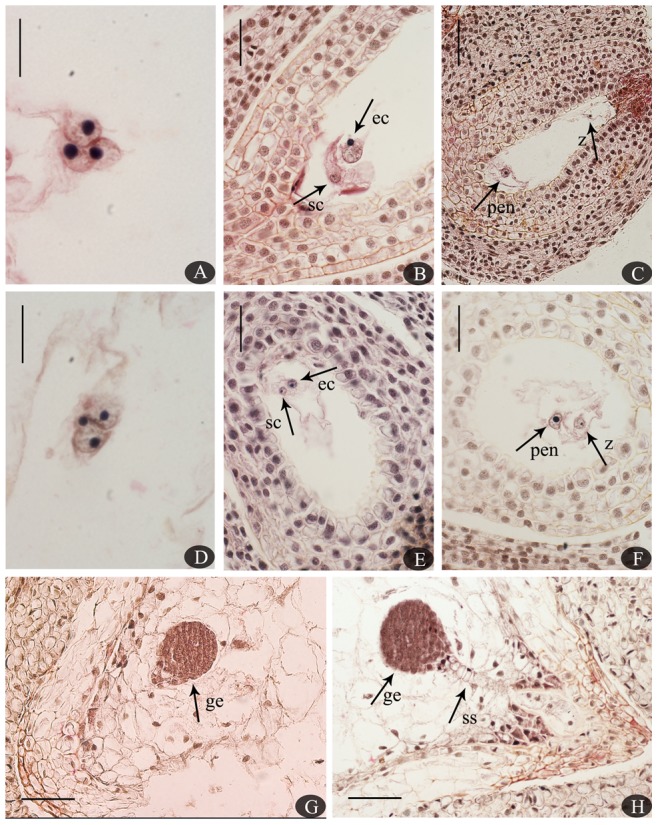
Normal double fertilization and early embryonic development after SP vs. CP in C. oleifera.(A). Polar nucleus fusion with a sperm nucleus 120 h after SP. (B). Sperm cell approaching an egg cell 96 h after SP. (C). A zygote and primary endosperm nucleus in an embryo sac 14 days after SP. (D). Polar nucleus fertilization 720 h after CP. (E). Sperm cell fused with an egg cell 6 days after CP. (F). A zygote and primary endosperm nucleus 10 days after CP. (G). A globular embryo 210 days after SP. (H). A globular embryo and suspensor 200 days after CP. Abbreviations: ec, egg cell; ge, globular embryo; pen, primary endosperm nucleus; sc, sperm cell; ss, suspensor; z, zygote. Bars: A, D = 1000 µm; B, E, F = 100 µm; C, G, H = 200 µm.